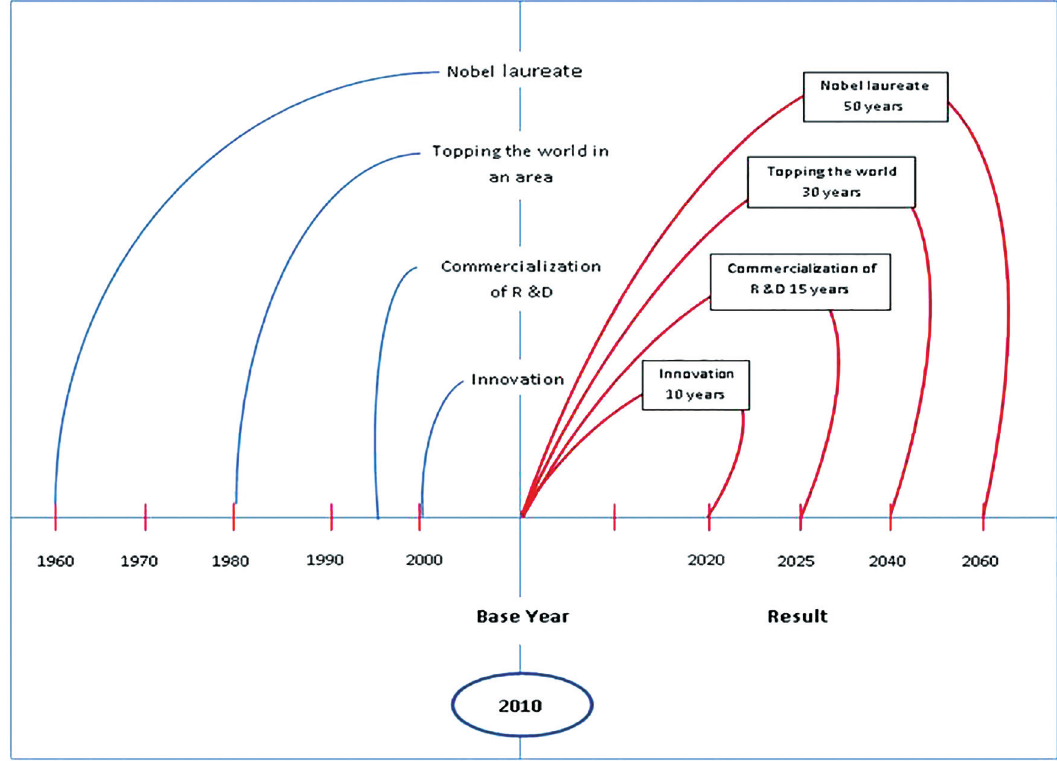
Figure 3 - Time Lags on Increase in HR and R&D Investments and the Resultant Key Indicators Stimulating Economic Growth. Source: Sustaining Malaysia’s Future, The Mega Science Agenda, 2011 (MSF 2010).